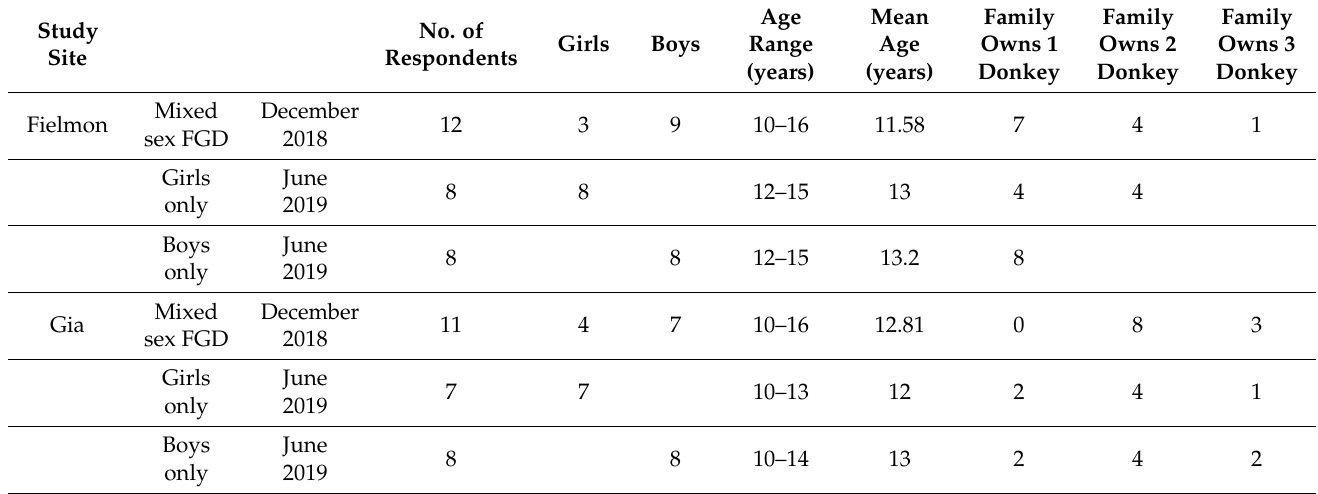
Table 1. Children’s Focus Group